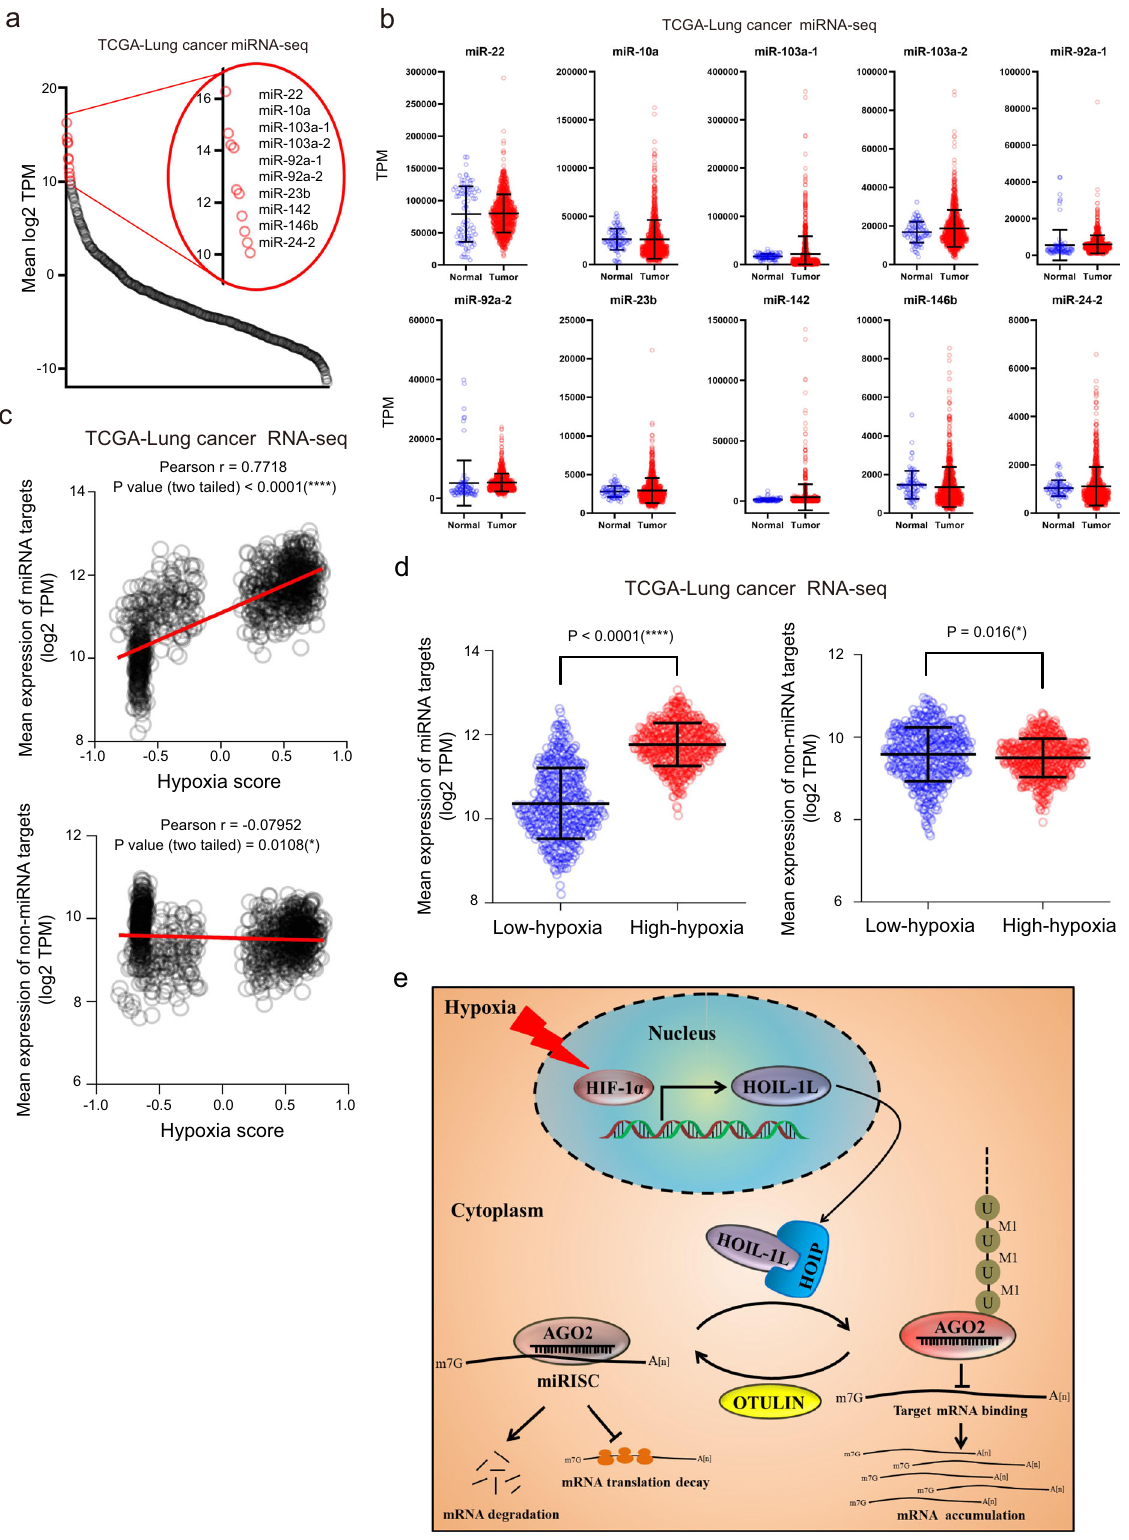
promotes AGO2 to form a functional hindered rather than normal miRISC. Subsequently, miRNA-targeted mRNAs cannot be loaded to the M1-Ubi modi fi ed AGO2/miRISC, thus the overall miRNA-targeted mRNAs are not degraded and stabilized in hypoxic tumor cells. By this mechanism, short-term hypoxia stress may protect overall mRNAs and enhances stress